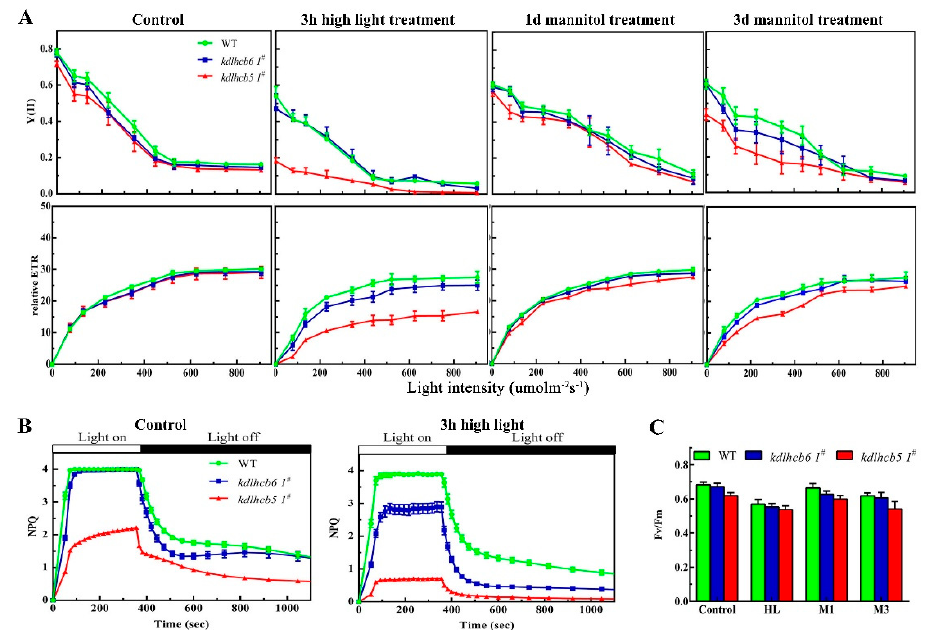
Figure 4. Detailed characterization of chlorophyll fluorescence in wild-type and mutants. ( A ) Light- response curves of PSII quantum yield and ETR in wild-type and mutants. ( B ) Time courses for induction and relaxation of non-photochemical quenching (NPQ) before, and after, 3 h of high light treatment. ( C ) The maximal photochemical efficiency of PSII. HL represents high light treatment for 3 h. M1 or M3 represent plants under 500 mM mannitol for 1 day or 3 days, respectively. The data represent the means ± SD of three biological replicates. Statistical significance compared with the wild-type p is indicated by asterisks (* p ≤ 0.05, Student’s t -test).